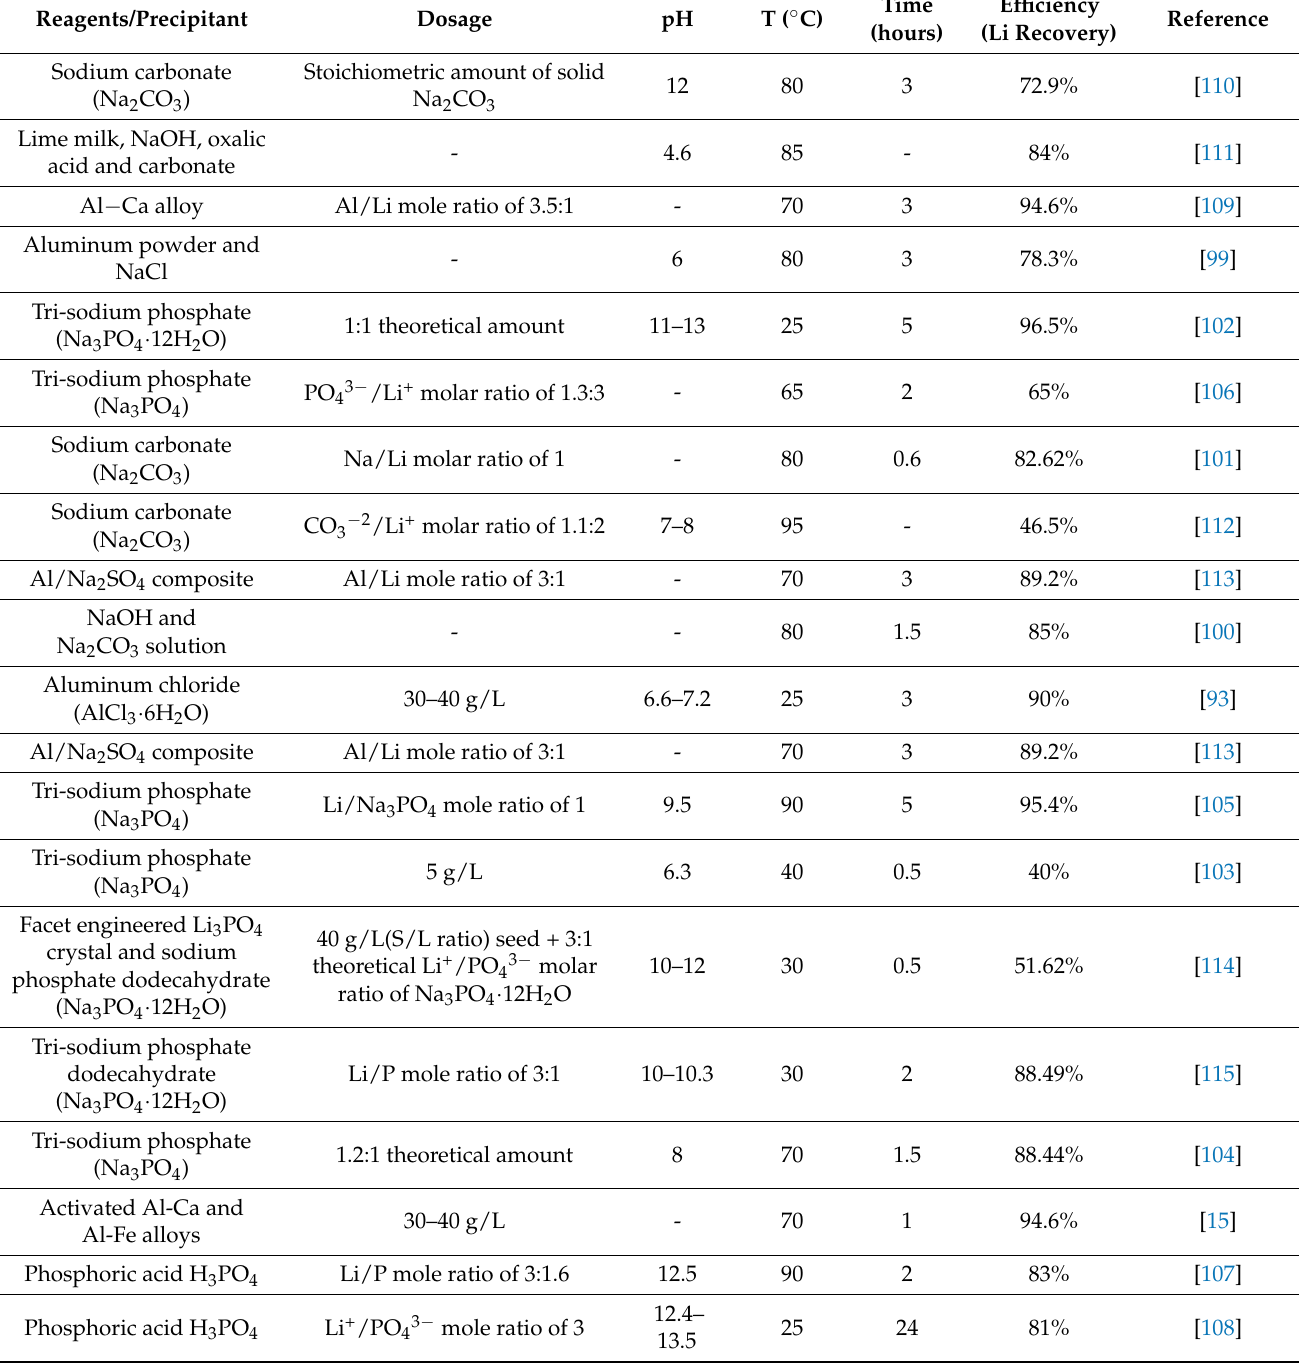
Table 1. Lithium recovery rate by precipitant at optimum operating